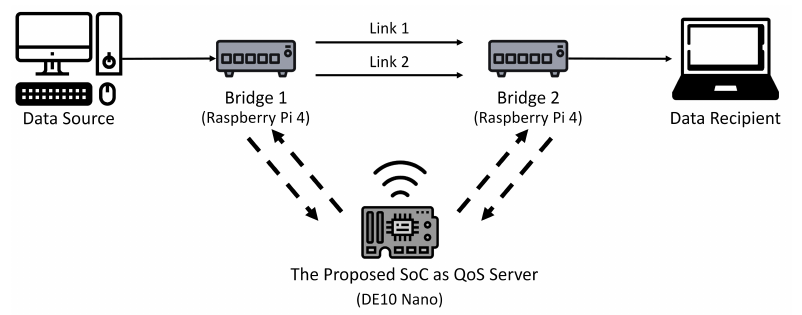
Figure 11. The real LAN for the experiments. The proposed SoC is deployed as the QoS server for the